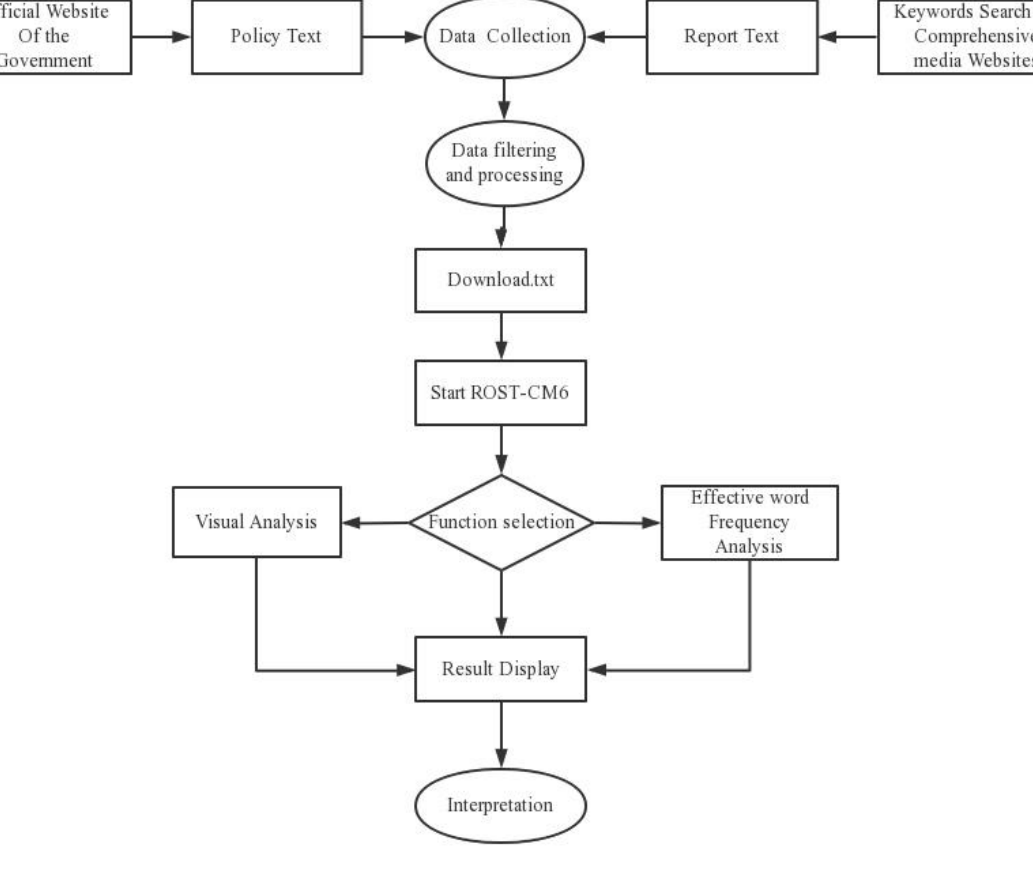
Figure 1. Research Figure 1. Research framework.